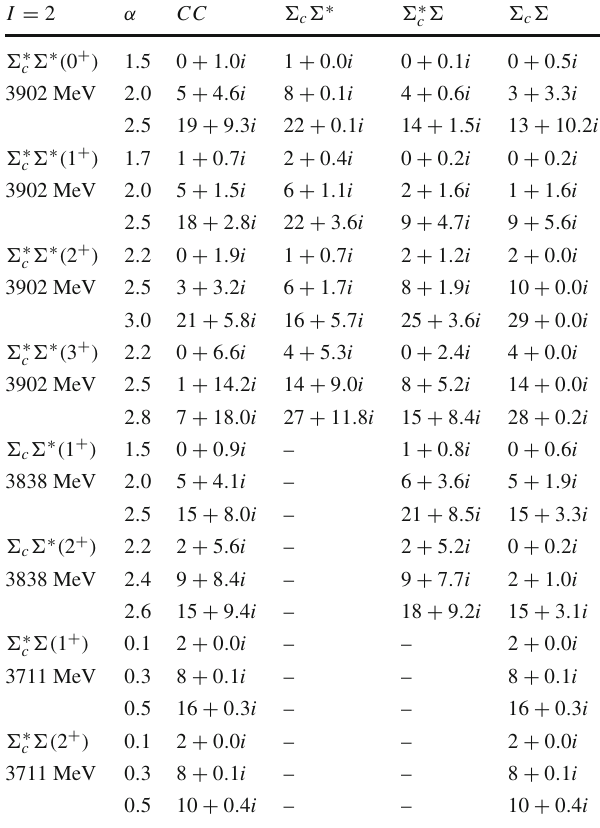
Table 6 The masses and widths of isotensor charmed-strange molec- ular states at different values of α . Other notations are the same as Table